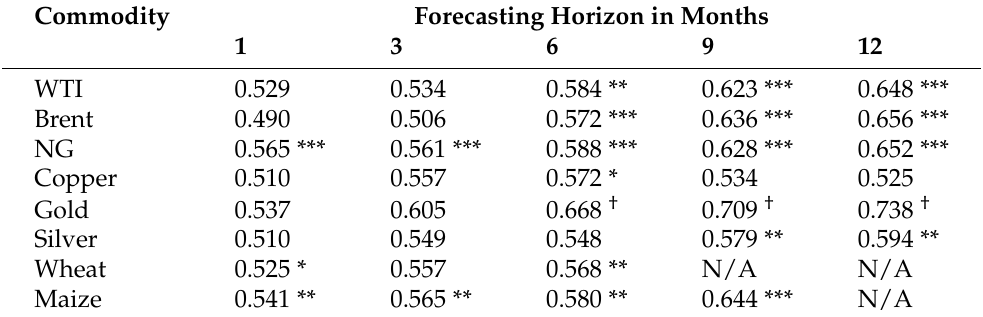
Table 2. Fractions of correct sign of change predictions for nominal commodity price